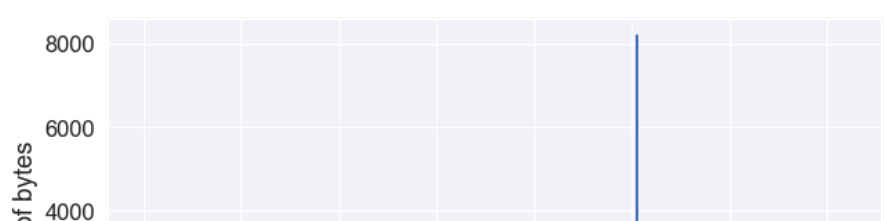
Figure 29. CPU utilization in S2.5.